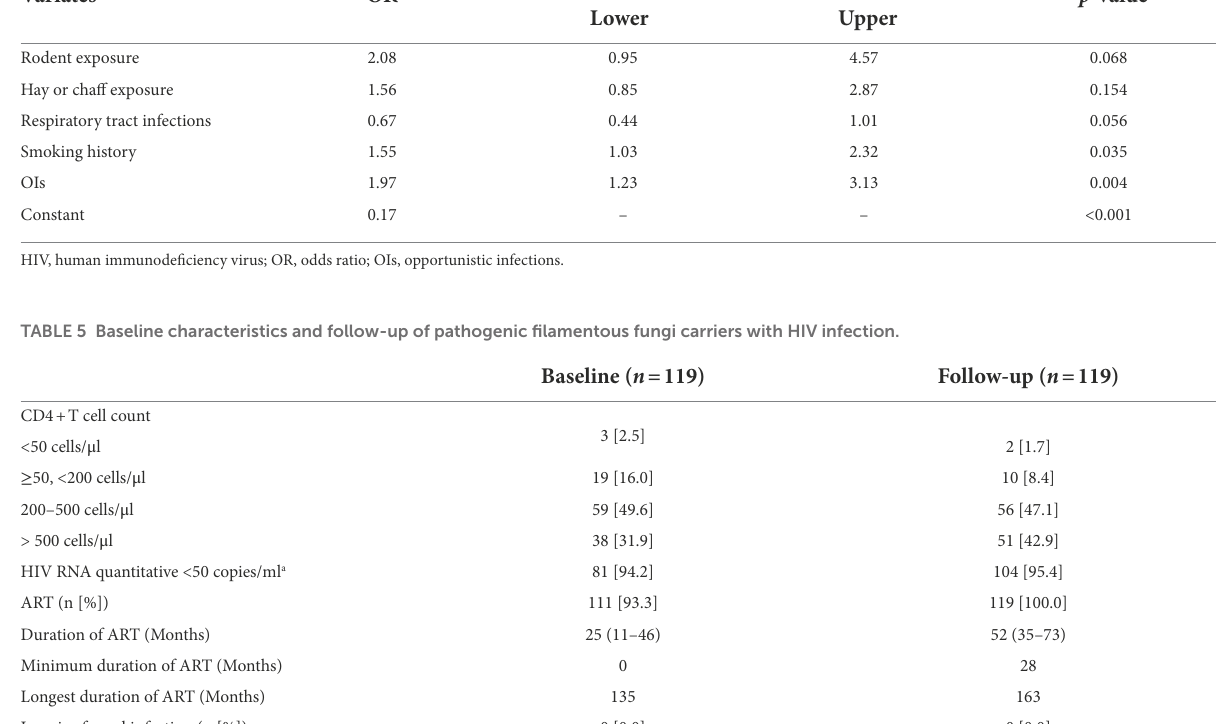
TABLE 4 Multivariate analysis of risk factors for pathogenic filamentous fungi carriage in HIV-infected group.